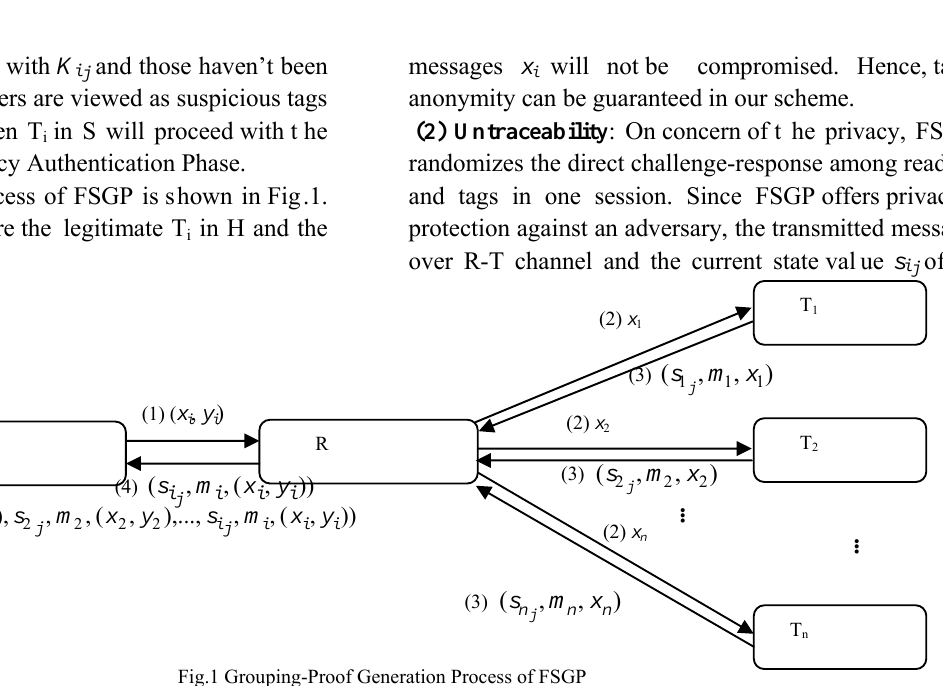
Fig.1 Grouping-Proof Generation Process of